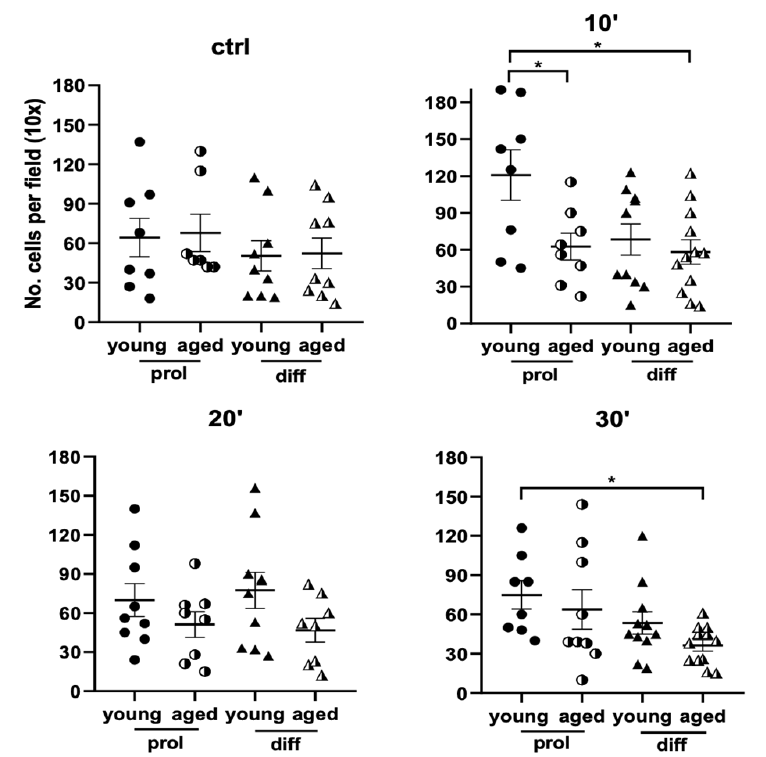
Figure 4. Effect of ViSS treatment on SC/myoblast number/field. Data from three different experiments are expressed as mean ± SEM. Hematoxylin-stained nuclei from 2 to 3 randomly selected fields for each group per experiment were counted at 10× magnification. Significance was determined with ordinary one-way ANOVA test, followed by Tukey’s multiple comparisons test. * p ≤ 0.05.